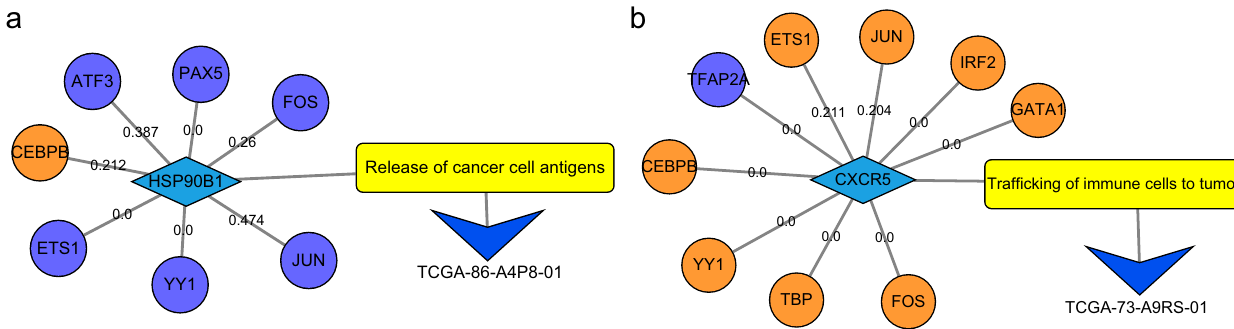
Fig. 5 The regulatory network according to the results of the ImmuCycReg framework. The orange circles are negative regulated TFs, the purple circles represent positive regulated TFs, the blue diamonds are IR genes, yellow rectangles are stages of immune cycle, and V-shaped triangles denote single sample. a The regulatory network of the HSP90B1 . b The regulatory network of the CXCR5 .